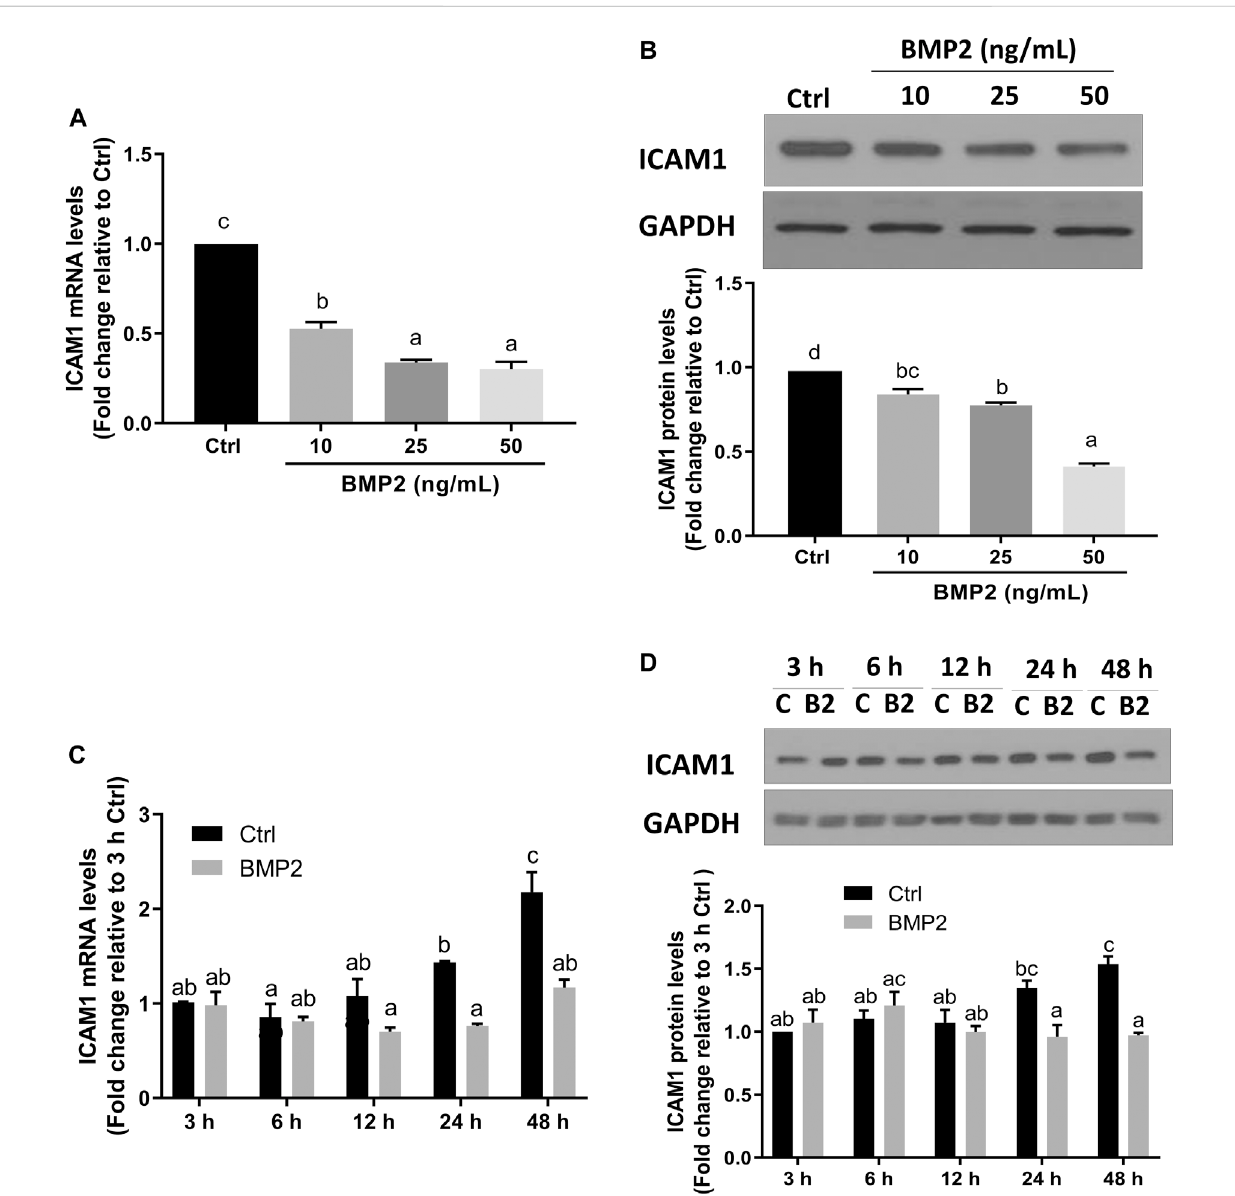
FIGURE 3 BMP2 downregulates the expression of ICAM1 in primary human endometrial stromal cells (HDSCs). (A,B) HDSCs (n = 3) were treated with different concentrations(0,10,25,50 ng/mL)ofBMP2for24 h,andthemRNA (A) andprotein (B) levelsofICAM1wereexaminedusingRT-qPCRandWesternblot analysis, respectively. (C,D) HDSCs (n = 3) were treated with 25 ng/mL of BMP2 for 3, 6, 12, 24 or 48 h, and the mRNA (C) and protein (D) levels of ICAM1 were examined using RT-qPCR and Western blot analysis, respectively. The results are expressed as the mean ± S.E.M. Each experiment was performed in duplicate. Different letters indicate a signi fi cant difference ( p < 0.05). C, Ctrl, Control; B2,